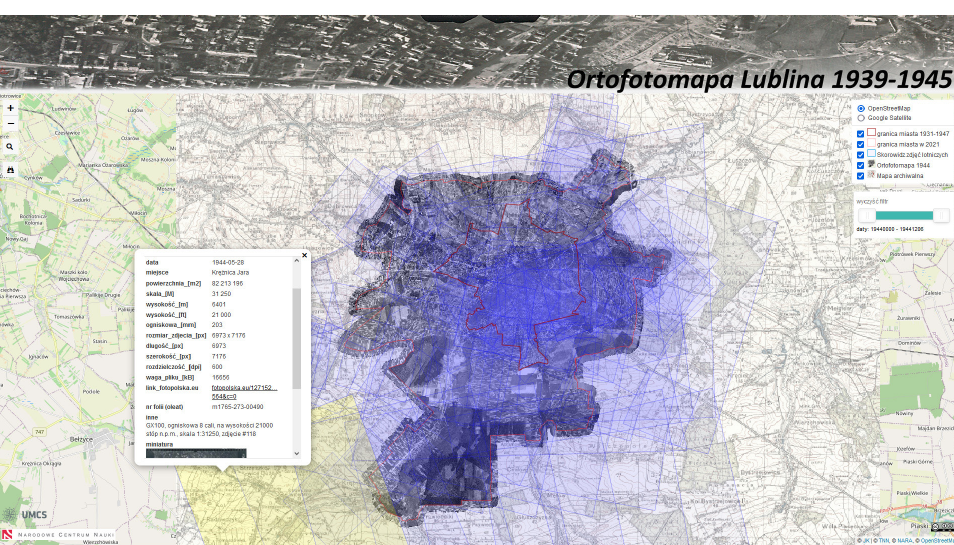
Fig. 10. ortolub.umcs.pl portal – the map application with historical orthophotomap layer and vector index. Own